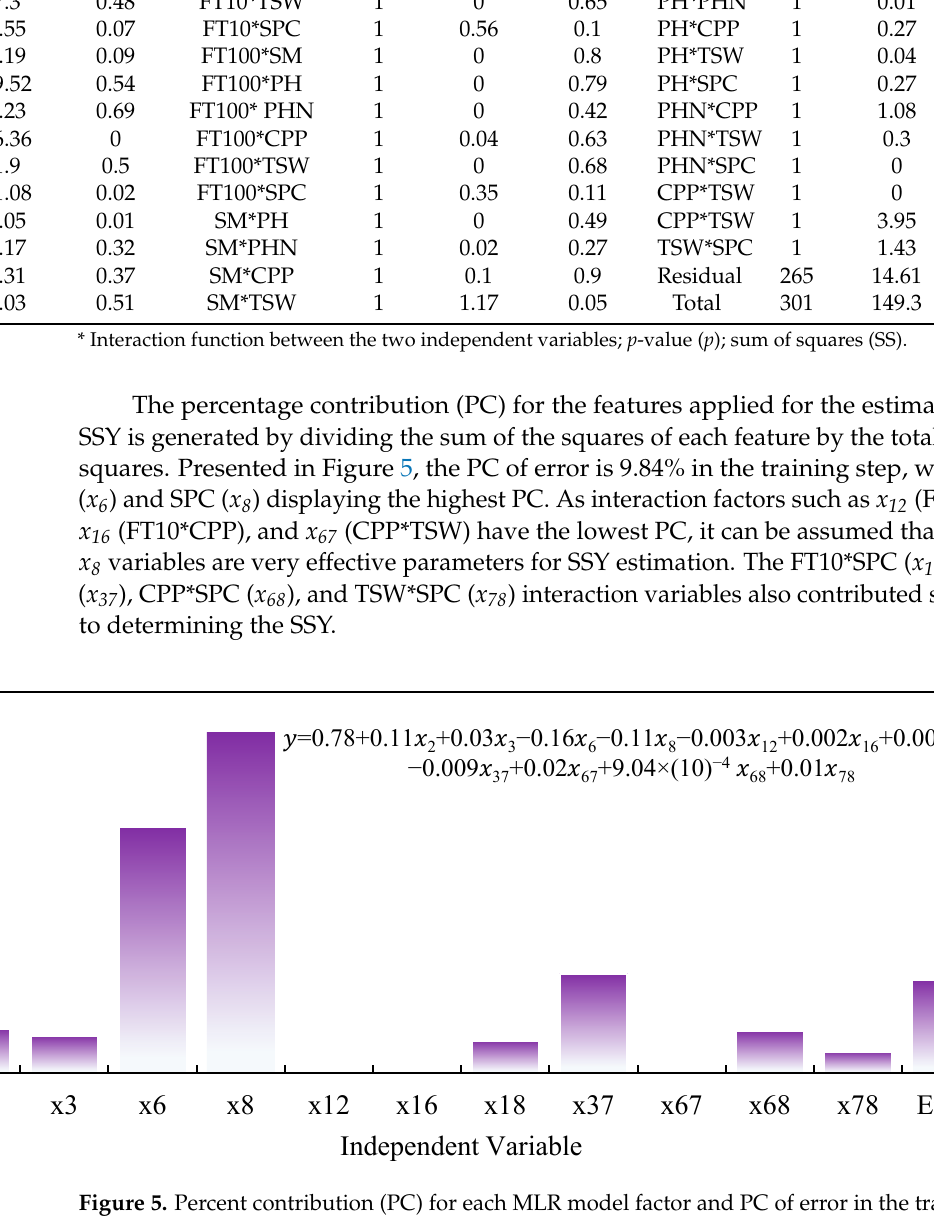
Table 6. MLR regression model ANOVA for the optimal training and validation dataset.